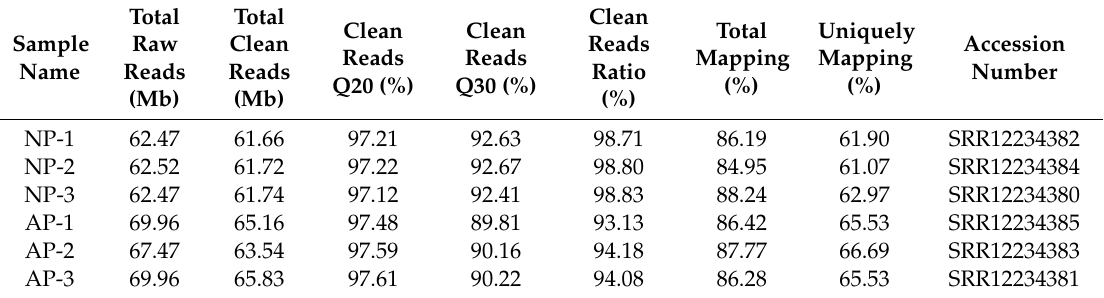
Table 1. An overview of sequencing assembly in normal and abortive pistils of Japanese apricot.